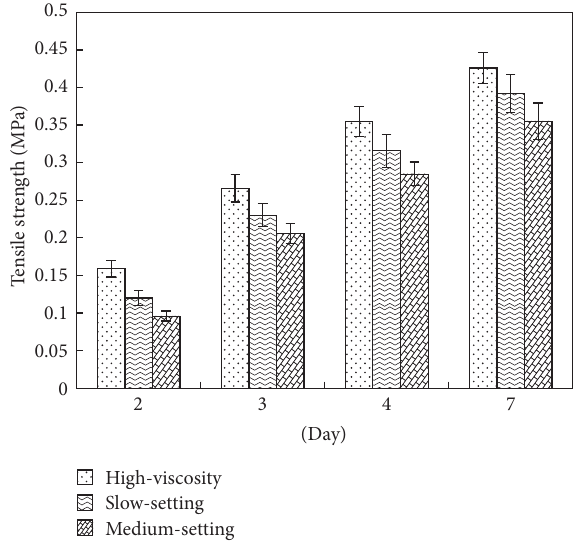
Figure 7: Tensile strength versus curing days for cold recycled asphalt mixtures with different types of emulsified asphalt.